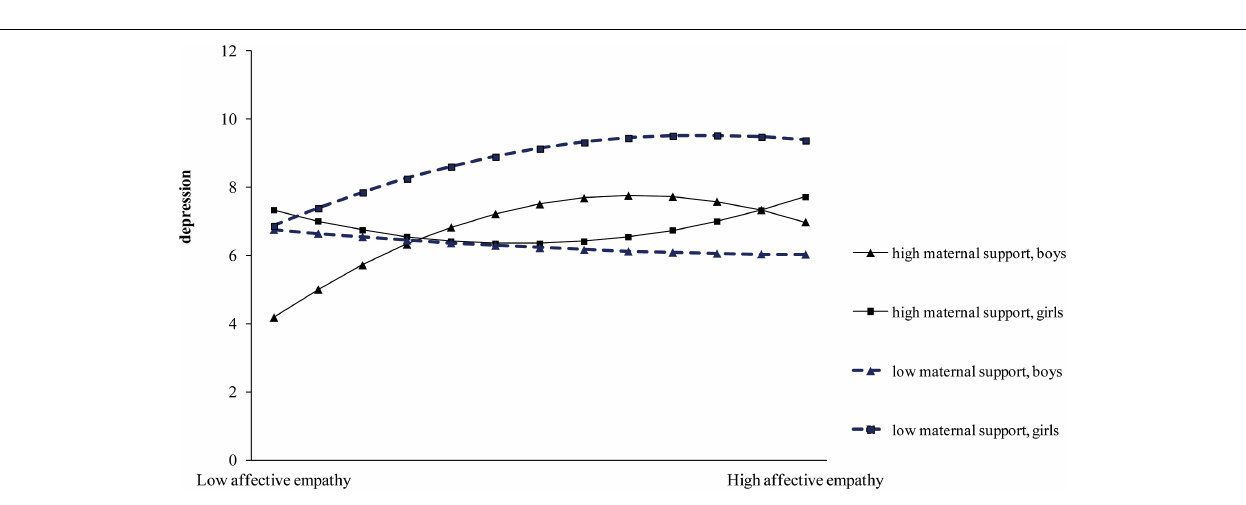
FIGURE 1 | Moderating effect of gender on the relationship between maternal support and depression (controlling for affective empathy).